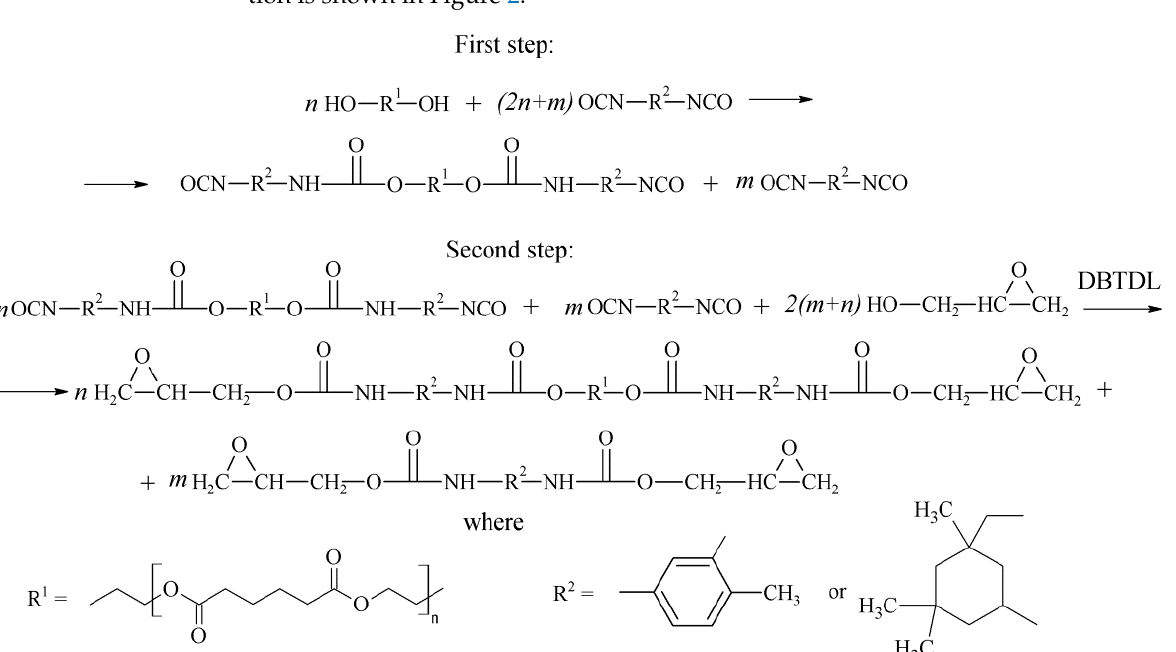
Table 1. Composition of polyester oligodiol.